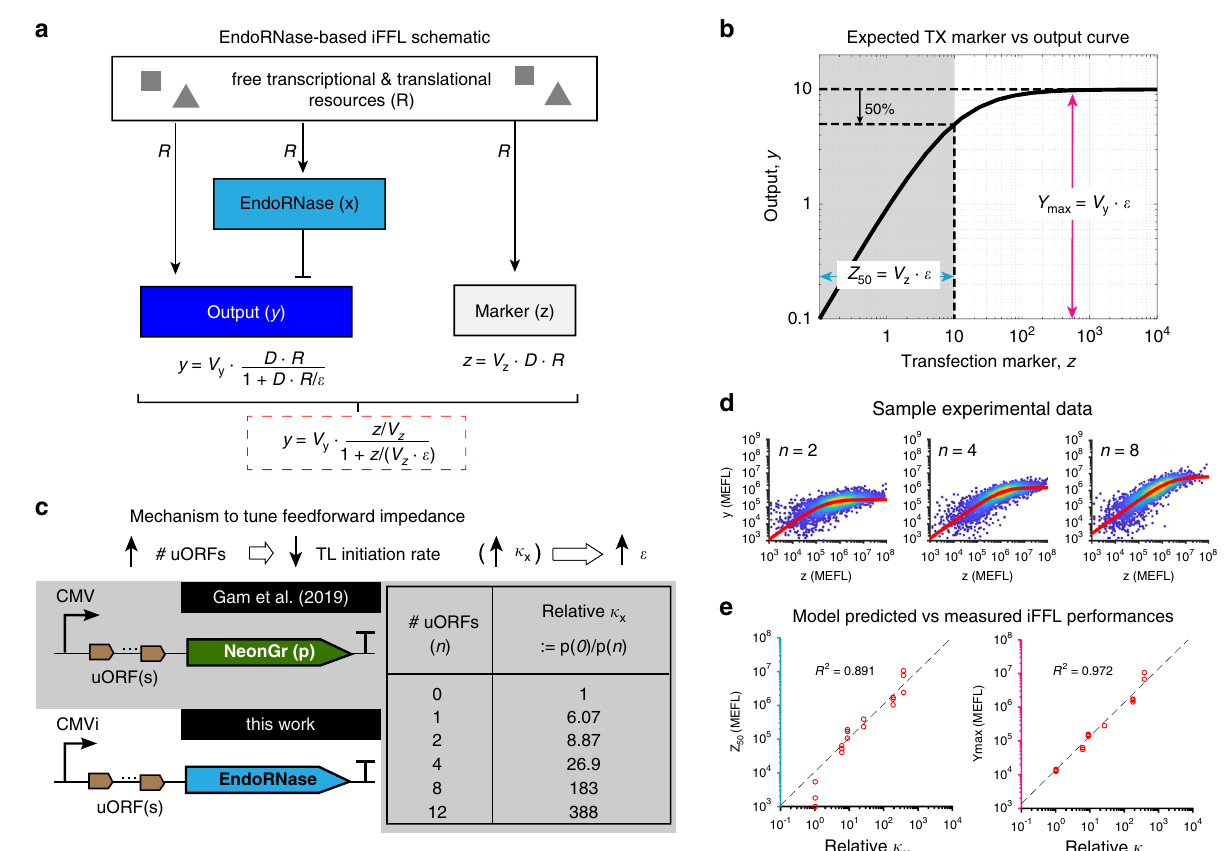
Fig. 3 Model-guided design and tuning of the endoRNase-based feedforward controller. a A schematic of the endoRNase-based feedforward controller. The expression of endoRNase ( x ), output ( y ), and TX marker ( z ) all use the same pool of transcriptional and translational resources ( R ). Parameters V y and ϵ are de fi ned in Eq. (2). Parameter V z is de fi ned in Eq. (85) in Supplementary Note 5. b The TX marker ( z ) vs output ( y ) dose – response curve computed from the model in Eq. (1). See “ Methods ” for derivation. The shape of this curve can be characterized by Y max and Z 50 , both of which are proportional to the feedforward impedance ϵ . c An increase in the number of upstream open-reading frames (uORFs) in the 5 ′ UTR of the endoRNase transcript leads to a decrease in its translation initiation rate. We model it as an increase in the dissociation constant between the ribosome and the endoRNase ’ s mRNA transcript ( κ x ), which increases ϵ . The relationship between the number of uORFs and the fold decrease in translation initiation (i.e., parameter κ x in the model) is summarized in the table using previously-published experimental data by Gam et al. 44 . d Sample experimental data (scatterplot) corresponding to n = 2, 4, 8 overlaid with TX marker vs output model fi tting (red solid line). n is the number of uORFs in the 5 ′ UTR of the Cas6-family endoRNase CasE (EcoCas6e). Experimental data are excerpted from Fig. 6b. e Comparison between experimentally measured Z 50 and Y max and the relative difference in ribosome – mRNA dissociation constant ( κ x ) for different numbers of uORFs in the 5 ′ UTR of the endoRNase. The experimental data are fi t to Eq. (3) to extract Z 50 and Y max (see “ Methods ” ). Fit parameters are provided in Source